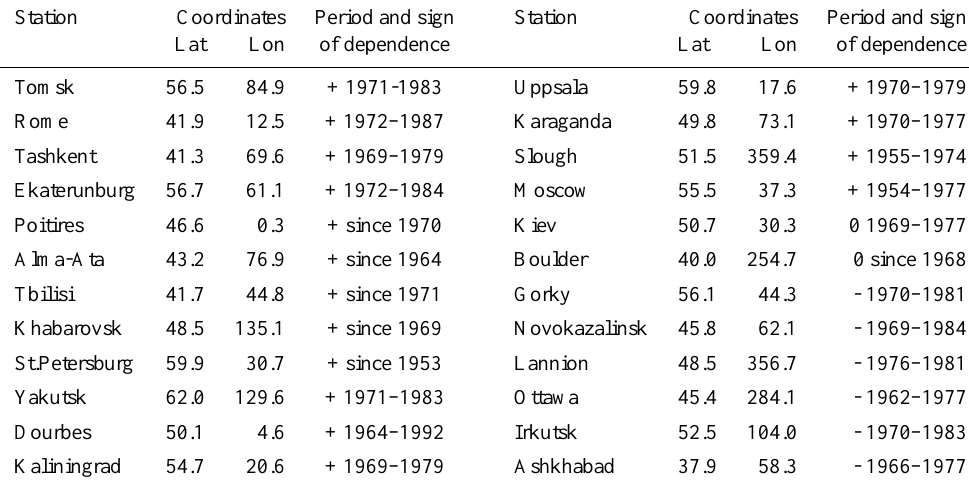
Table 1. The sign of the δ fo E 132 versus Ap 132 dependence (“+” – direct, “-” – inverse) and years during which it persists. Symbol “0” means the absence of any pronounced dependence Station Coordinates Period and sign Station Coordinates Period and sign Lat Lon of dependence Lat Lon of dependence Tomsk 56.5 84.9 +